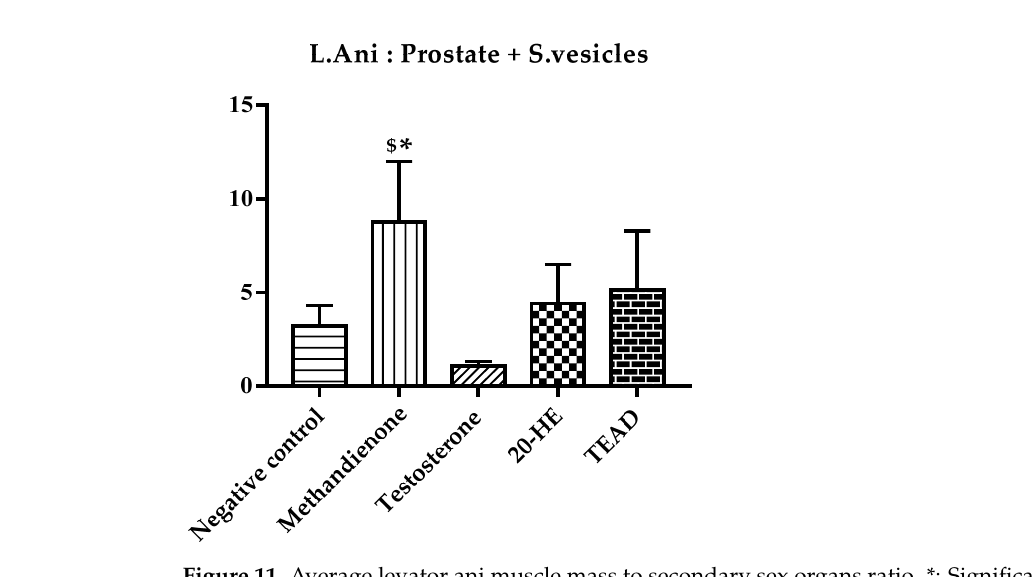
Figure 10. Average muscle bundle mass to secondary sex organs ratio. *: Significantly different from the negative control group at p < 0.001. $ : Significantly different from the testosterone group at p = 0.0011.